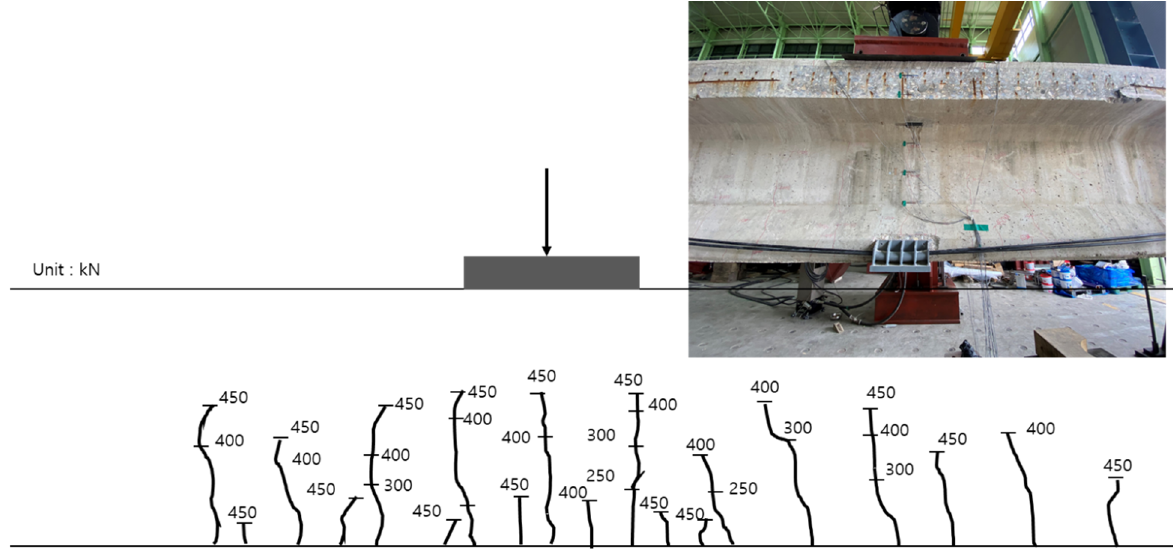
Figure 14. Crack map according to the load before reinforcement using the EP method.